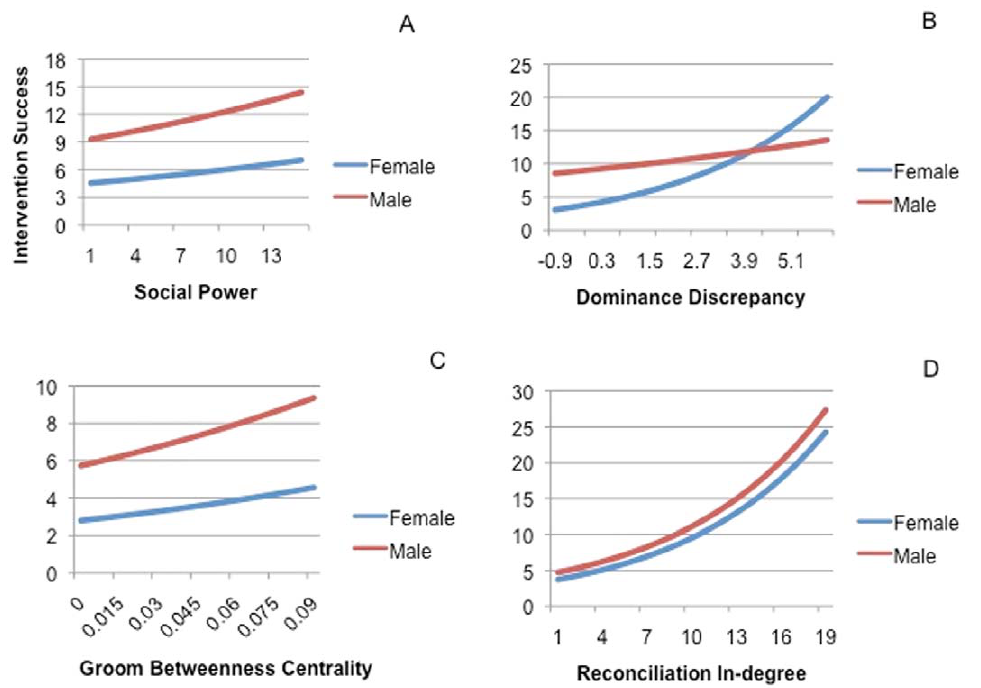
Figure 1. Relationship between intervention success and (a) social power, (b) dominance discrepancy, (c) groom betweenness centrality and (d) reconciliation in-degree for males and females at the individual level. show significantly higher social power than related males (ß = 2 0.32, p = 0.45).